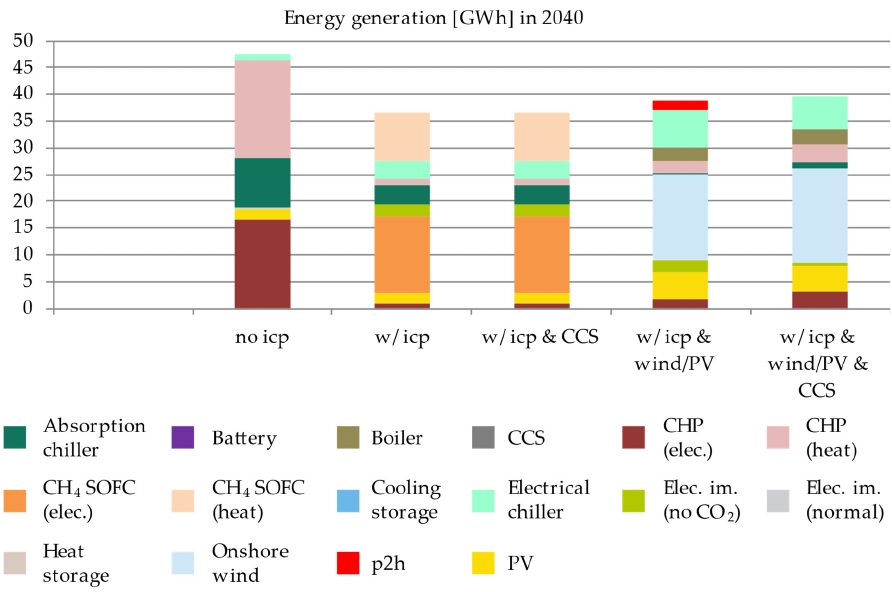
Figure 4. Energy generation for the German scenarios in 2040. Table 7. Cost and emission overview for the German scenarios.